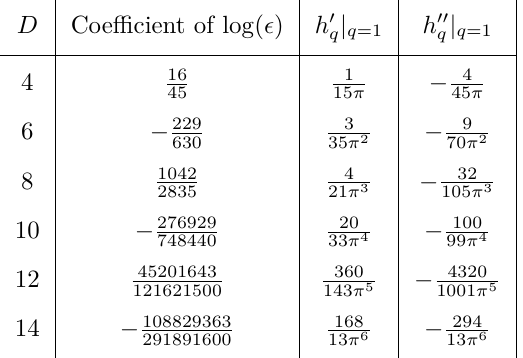
Table 1 . Entanglement entropies conformal D obtained using conformal